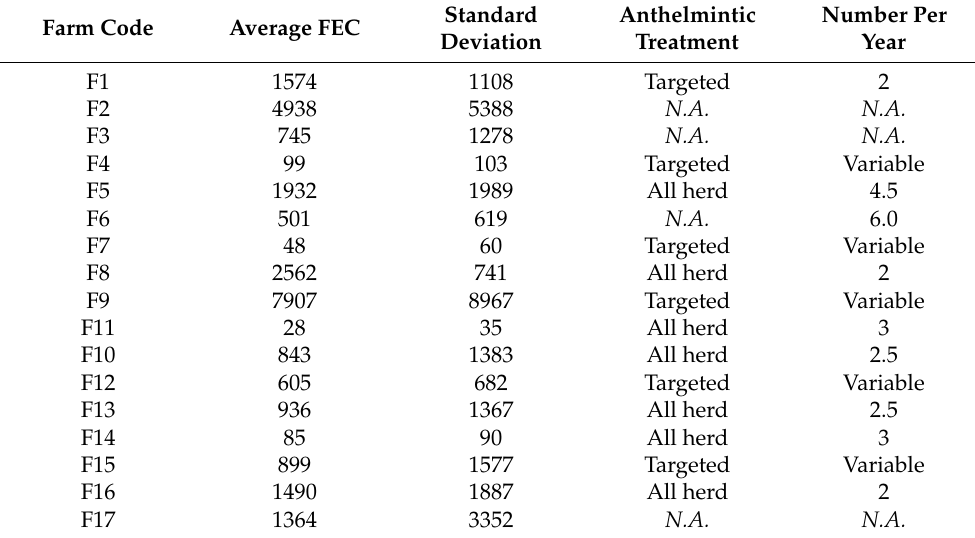
Table 2. Anthelmintic treatment management by farmers and fecal egg counts (FEC) of gastrointesti- nal nematodes. N.A., not